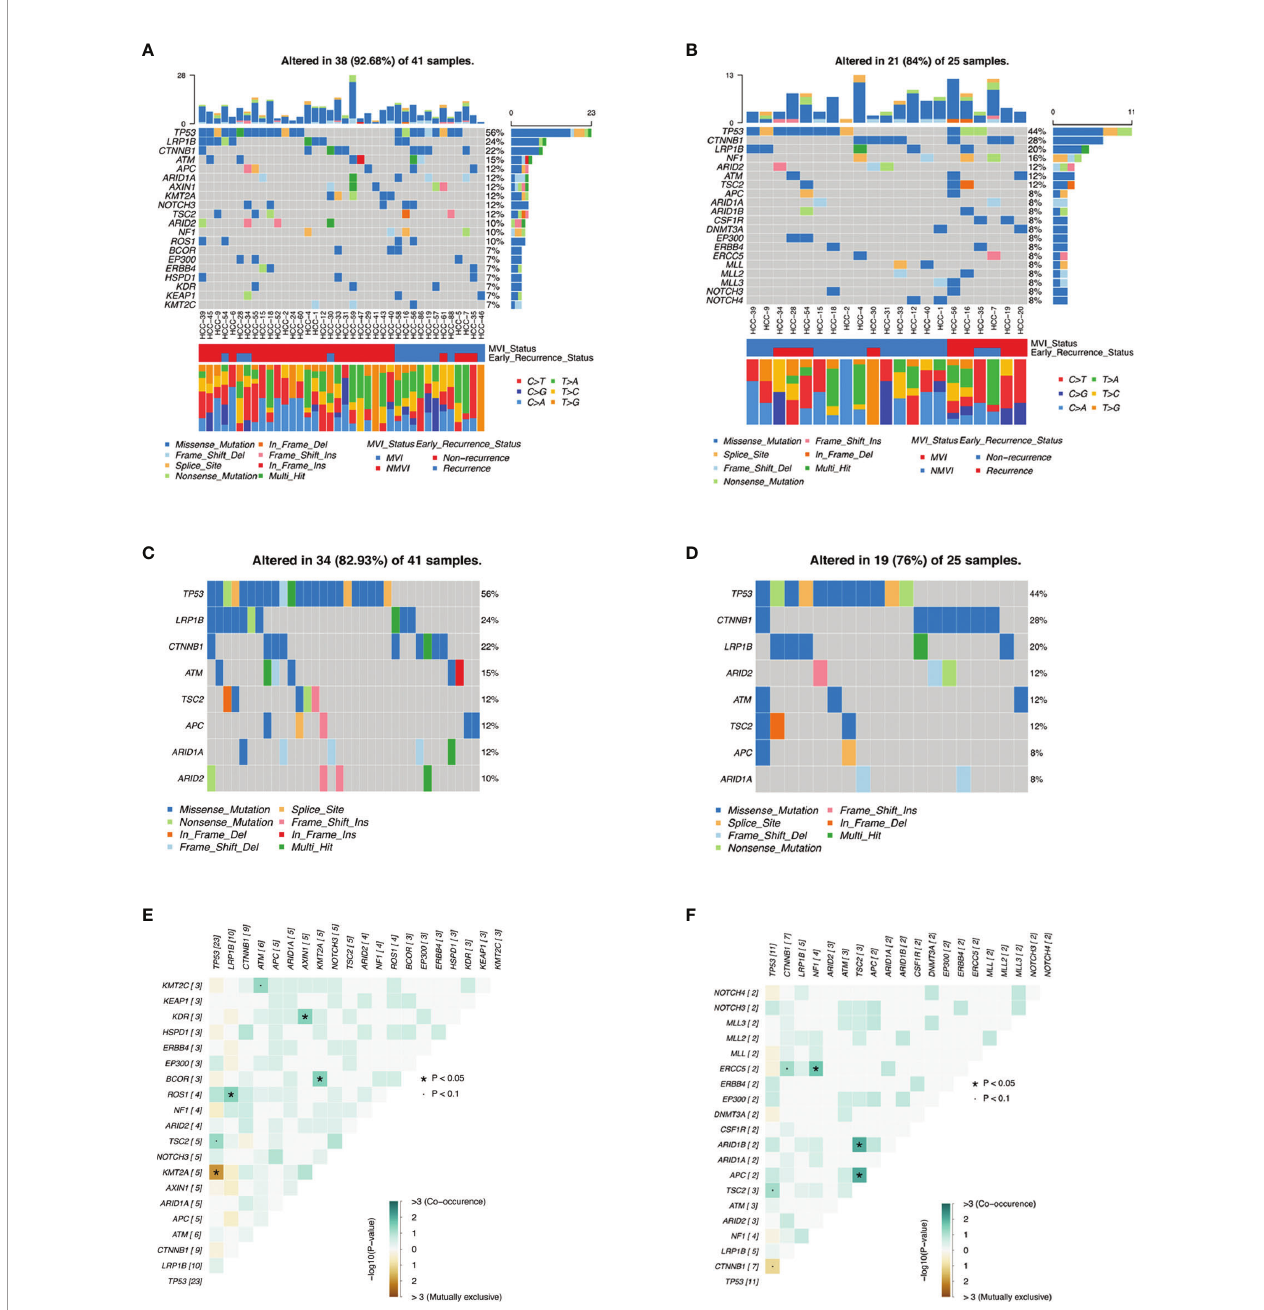
FIGURE 2 | Genomic landscape of mutations in HCC cohorts. (A, B) are heatmaps illustrating top 20 mutant genes of tumor tissues and ctDNA samples in our HCC patients, respectively, with MVI status groups and early-recurrence status groups as well as guanine transformation types. (C, D) are heatmaps illustrating concordant genes between top 20 mutant genes of tumor tissues and top 20 mutant genes of ctDNA, respectively. (E, F) demonstrate somatic interactions via exclusive/co-occurrence event analysis on top 20 mutated genes in tumor tissue samples and ctDNA samples,